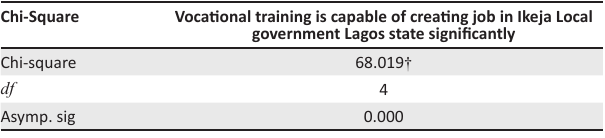
TABLE 3: Chi square ( X 2 ) test statistics (Statistical Package for Social Sciences). Chi-Square